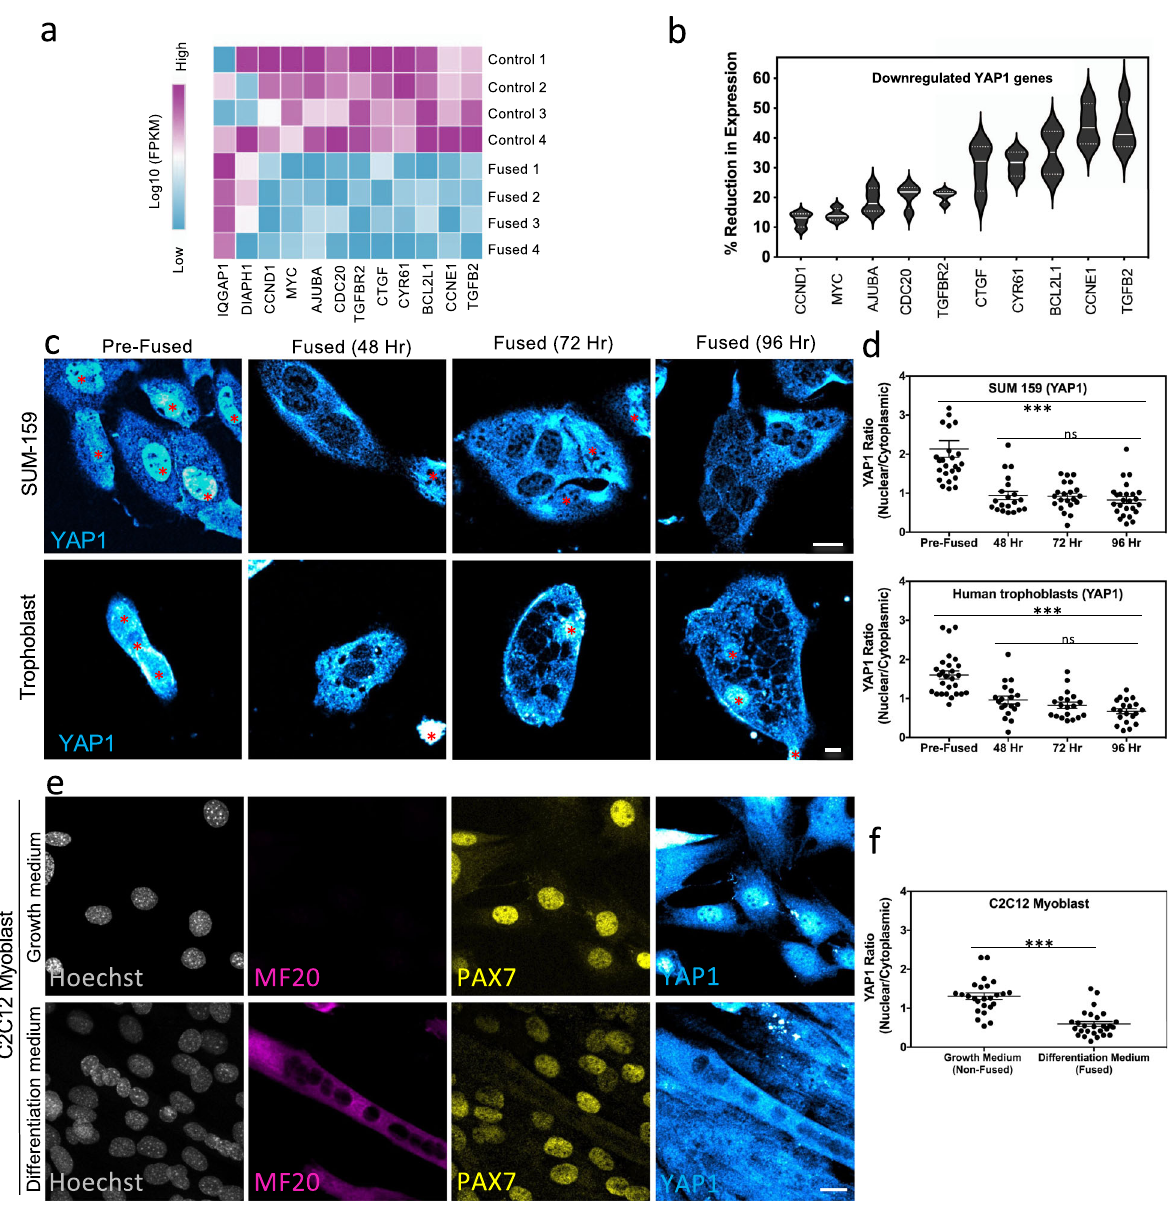
Fig. 3 Cell fusion leads to YAP1 inhibition and cytoplasmic localization. a Heatmap representing the expression levels (Log10 FPKM) of transcripts from genes known to be in fl uenced by YAP1 activity in non-fused unwashed control and fused cells ( n = 4 independent experiments). b Violin plots represent the average percent decrease in transcript levels from n = 4 independent cell fusion experiments. The analysis focuses on transcripts known to be in fl uenced by YAP1 activity. Confocal images of YAP1 immunostained VSV-G transfected SUM-159 cells ( c , top panel) and isolated primary human trophoblast cells that fuse in culture without induction ( c , bottom panel) either before or after fusion were quanti fi ed ( d ) to measure changes in the localization of YAP1. Representative images are shown. Red * marks non-fused cells. (Top panel) Error bars represent the SEM, n = 26, n = 20, n = 21, and n = 25 cells examined over three independent experiments for pre-fused and cells 48, 72, and 96 h after fusion, respectively. *** p < 0.0001. (Bottom panel) Error bars represent the SEM, n = 27, n = 19, n = 19, and n = 20 cells examined over three independent experiments for primary human trophoblast prior to fusion or left to fuse in culture during 48, 72, and 96 h, respectively. *** p < 0.0001. e C2C12 myoblast fusion experiments were performed. Control cells incubated in growth media were fi xed after 2 days. Cells induced to fused were incubated in differentiation media for 4 days and then were fi xed. C2C12 cells were immunostained and imaged by confocal microscopy to determine YAP1 localization. Proliferative C2C12 were labeled using PAX7 antibodies while fused muscle cells were labeled using MF20 antibodies. f The nuclear/cytoplasmic ratio of YAP1 before and after cell fusion of C2C12 myoblast cells was calculated. Error bars represent the SEM, n = 25 and n = 27 cells examined over three independent experiments for cells in growth or differentiation media, respectively. *** p < 0.0001. ns not signi fi cant ( p > 0.05). Statistical signi fi cance calculations were performed using a two-tailed unpaired Student ’ s t test. Scale bar size = 10 μ mouse embryos (E10.5) and could see YAP1 present in the nuclei of PAX7-positive progenitor cells. In MF20-positive cells, overall the nuclear to cytoplasmic ratio of YAP1 is signi fi cantly lower in YAP1 levels are reduced, consistent with YAP1 degradation the MF20-positive syncytia (Fig. 3e, f) 61 . We also examined YAP1 which is known to follow YAP1 inhibition (Supplementary in tissue sections from mouse skeletal muscle in developing